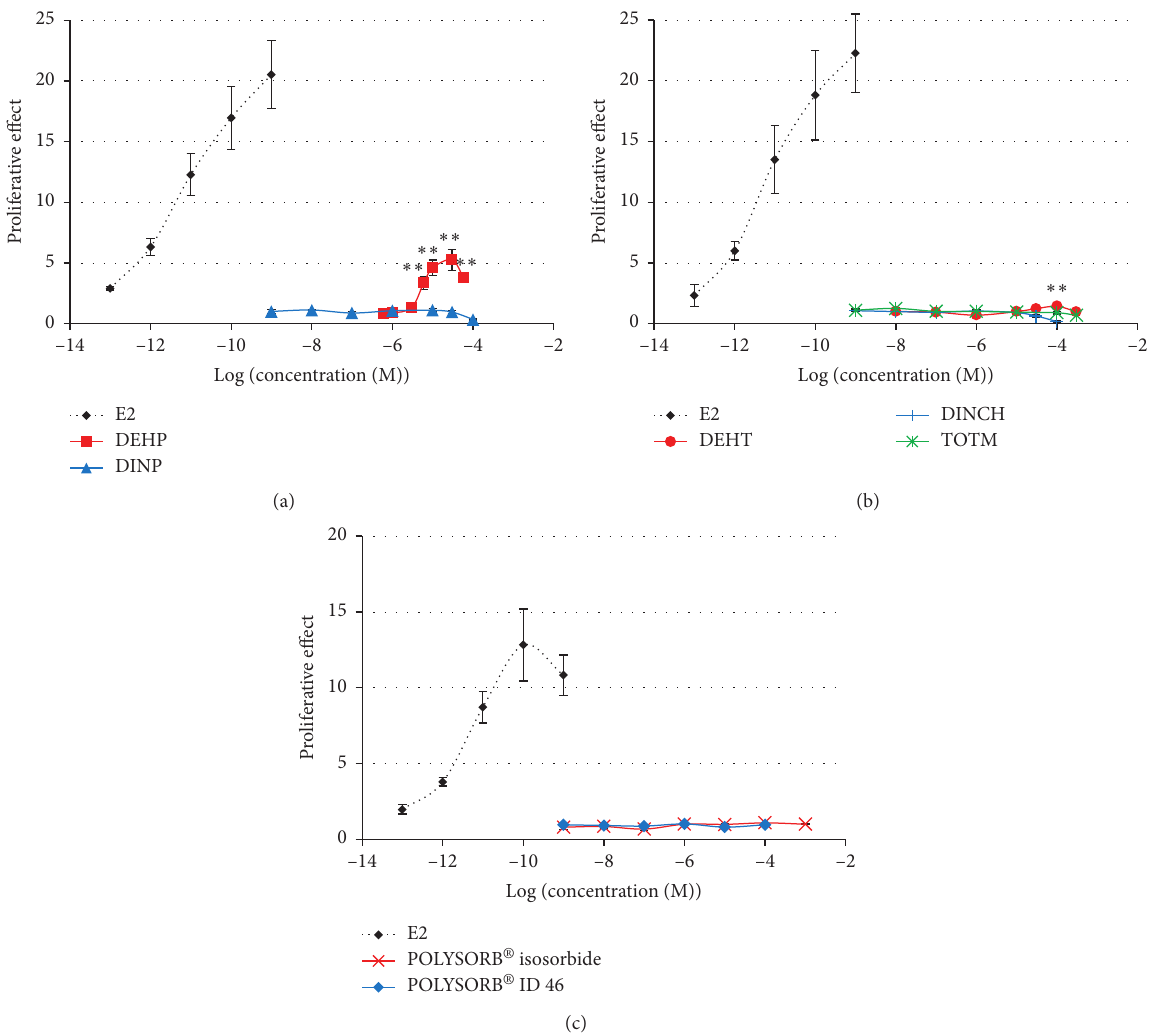
Figure 1: Estrogenic activity of phthalates and substitutes in the E-Screen agonist assay. MCF-7 cells were exposed for 120 h to different concentrations of DEHP, DINP (a), DEHT, DINCH, TOTM (b), POLYSORB ® isosorbide, or POLYSORB ® ID 46 (c). Results represent the mean proliferative effect compared to SC ( � 1) ± SD of 3 replicates from one representative assay out of 2 assays. ∗∗ Statistically significant increase compared to SC ( p < 0 . 01). In the competitive confirmation assay (Figure 2), the cell proliferation induced by 30 μ M DEHP was statistically significantly decreased in the presence of the reference antiestrogen ICI 182,780. This confirms that the DEHP-induced MCF-7 cell proliferation was mediated by an estrogenic